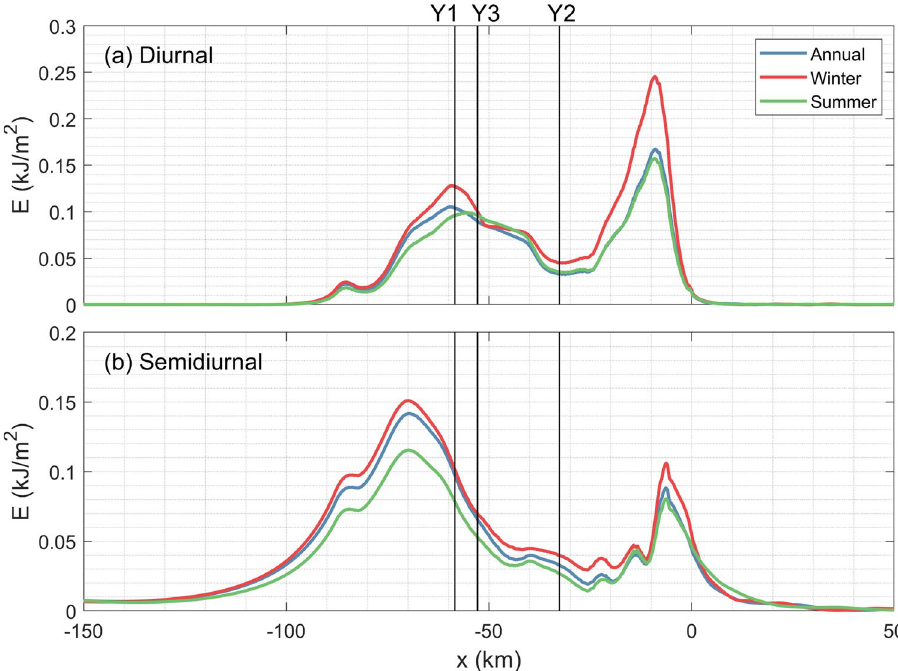
Figure 11. Depth-integrated ( a ) diurnal and ( d ) semidiurnal energy with different